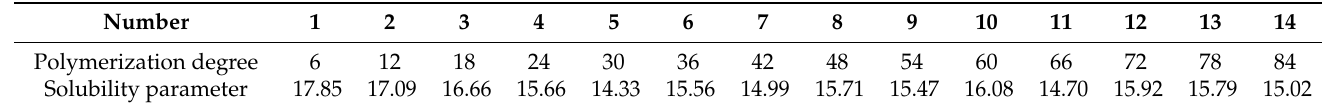
Table 4. Solubility parameters of different PE